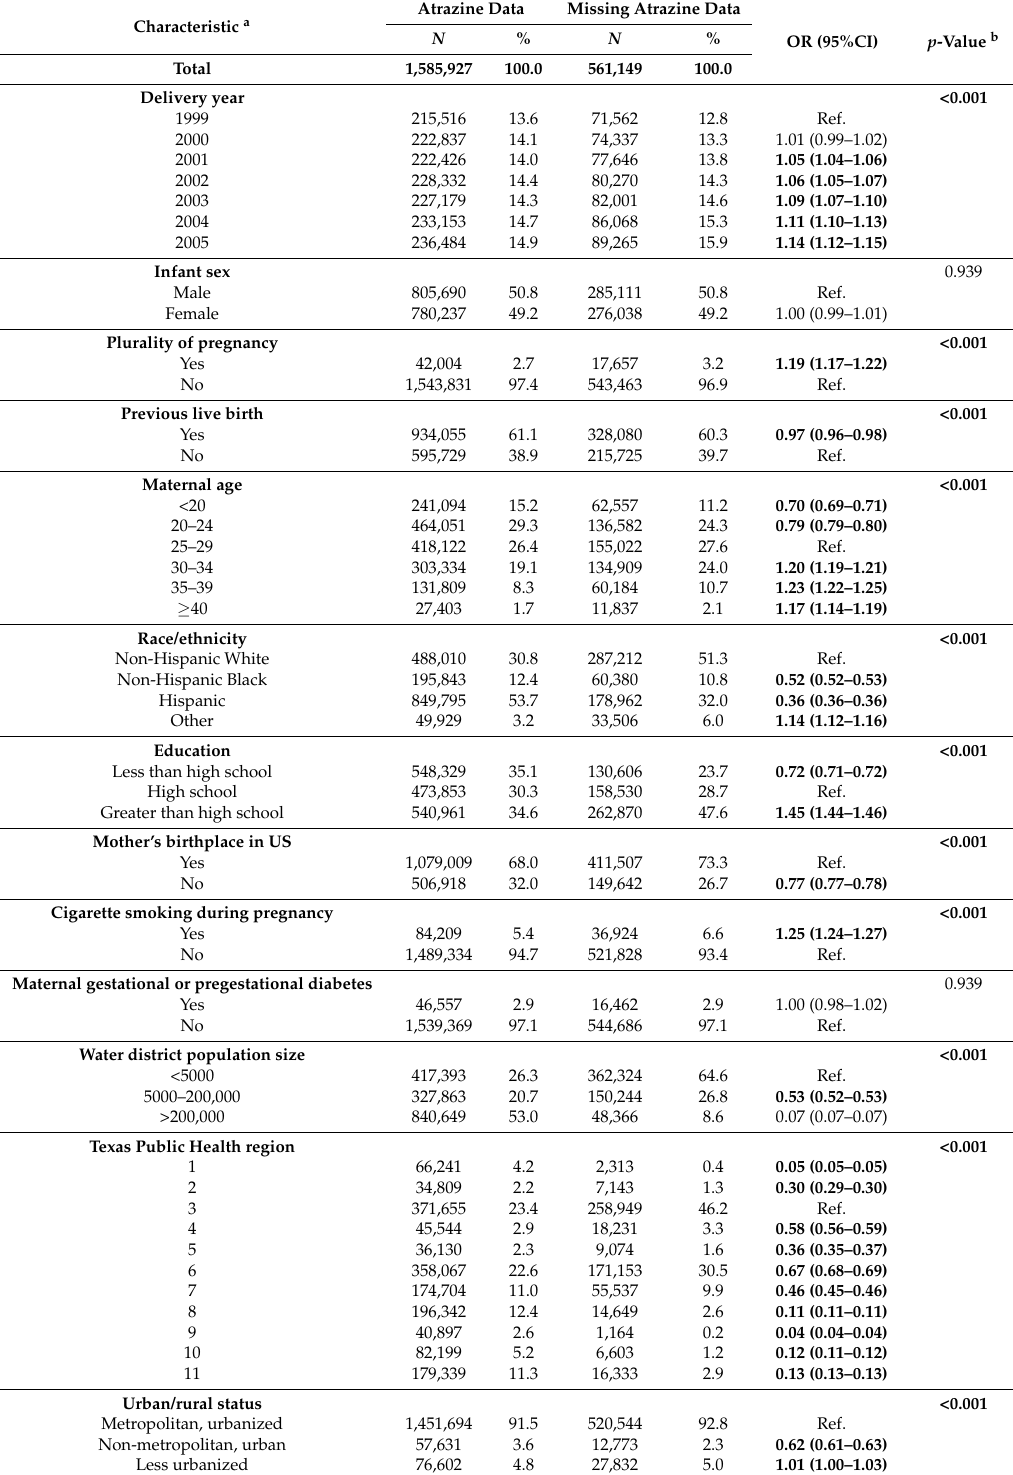
Table 2. Descriptive characteristics of potential controls with and without atrazine data in Texas,